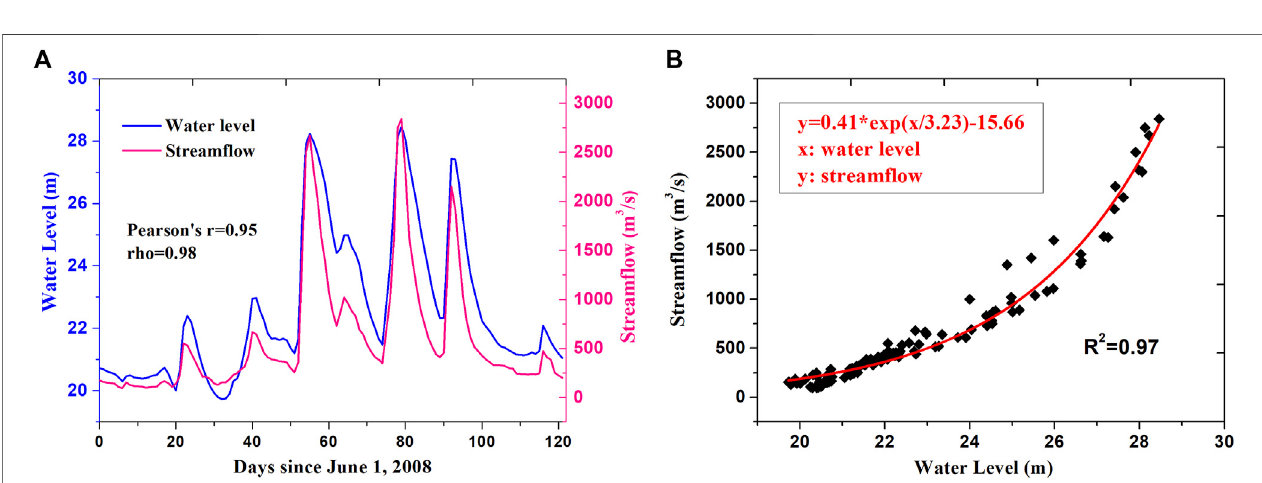
FIGURE4| Observeddailywaterlevelandstream fl ow (A) andtheexponential fi ttingbetweenwaterlevelandstream fl ow (B) inthe fl oodseasonof2008intheWJB sub-basin.